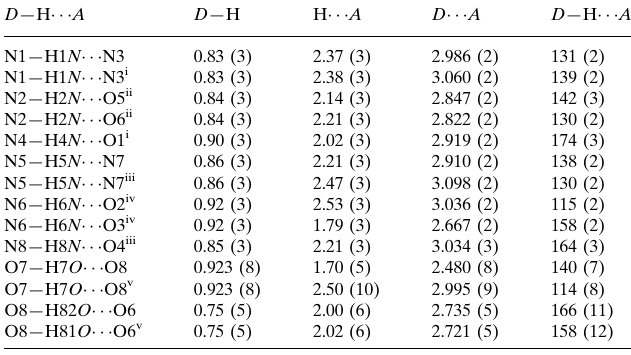
Key indicators: single-crystal X-ray study; T = 200 K; mean (cid:1) (C–C) = 0.004 A˚; disorder in solvent or counterion; R factor = 0.052; wR factor = 0.156; data-to- parameter ratio = 14.9.